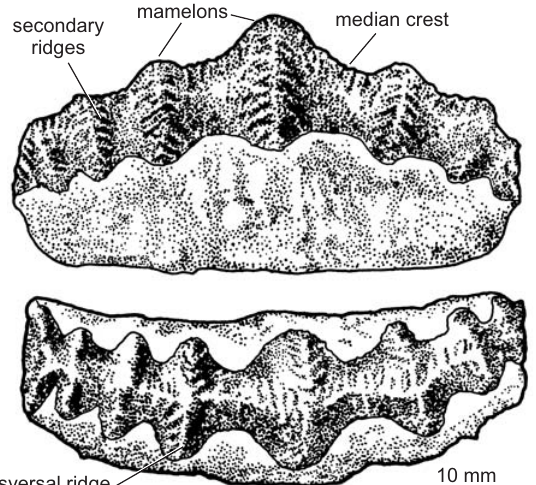
Fig. 4. Morphological terminology of the teeth of Campodus agassizianus De Koninck, 1844. The drawing based on Lohest’s (1884) Belgian material re-illustrated in Ginter et al. (2010).